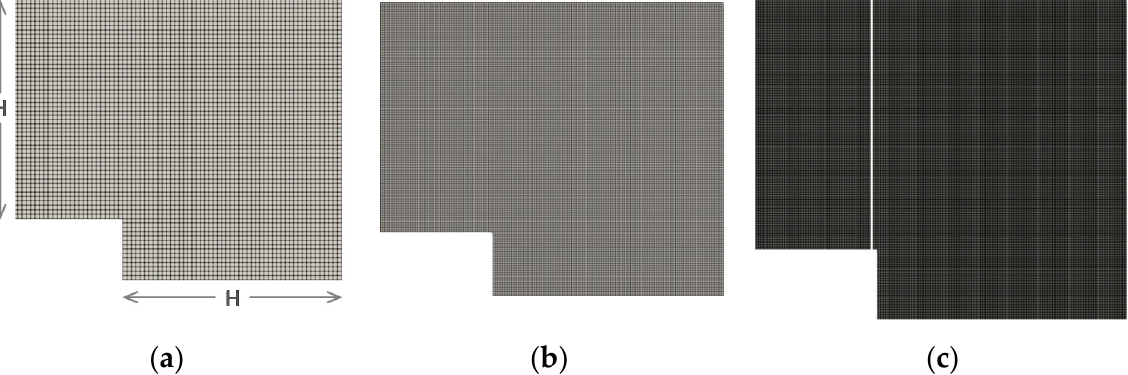
Figure 2. Uniform meshing size progression: ( a ) coarse, Δ x = Δ y = 1/50·H; ( b ) medium, Δ x = Δ y = 1/100·H; ( c ) fine, Δ x = Δ y = 1/200·H.